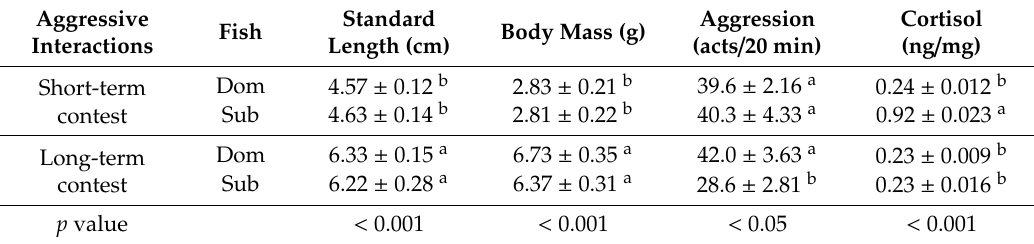
Table 1. Cortisol levels, aggression (aggressive acts per 20 min) and growth performance in dominant (Dom) and subordinate (Sub) black rockfish. Different letters indicate significant difference among these four groups, which were detected by one-way analysis of variance (ANOVA) ( p < 0.05). Values are mean ± S.E. ( n = 12).